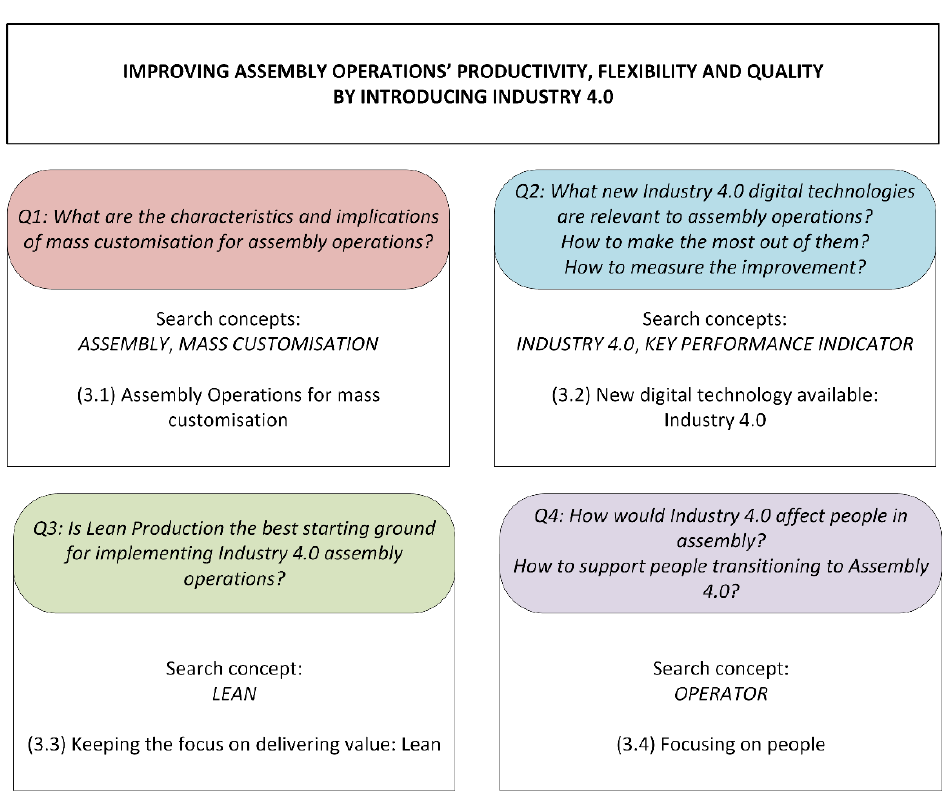
Figure 4. Research questions, search key concepts and their relationship to the literature review analysis topics.